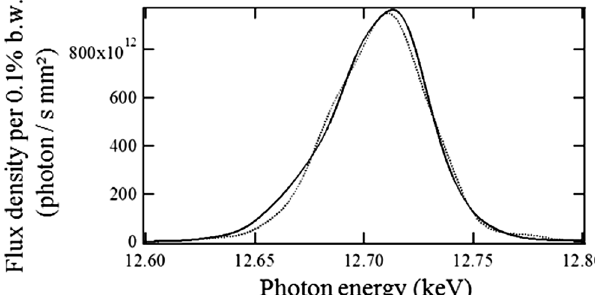
FIG. 8. Flux density radiated by the round electron beam (horizontal and vertical sizes and divergences are equal to 60 . 3 μ m and 6 . 6 μ rad respectively) taking into account the modified electron trajectories in the presence of ( B 1 ¼ 10 T, solid line) and without ( B 1 ¼ 0 T, dashed line) solenoid field effect. The electron beam enters the undulator on axis with zero angle.